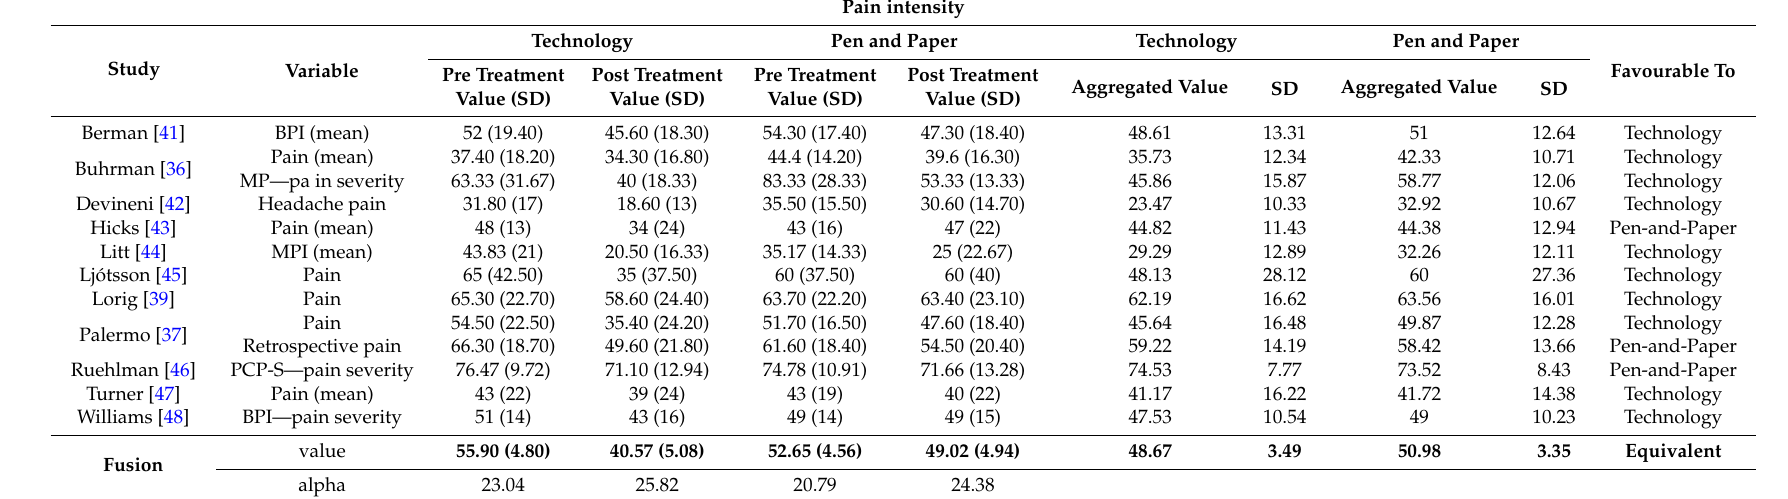
Table 1. Comparison between pen-and-paper, and mobile and web technology using pre and post treatment results by study and